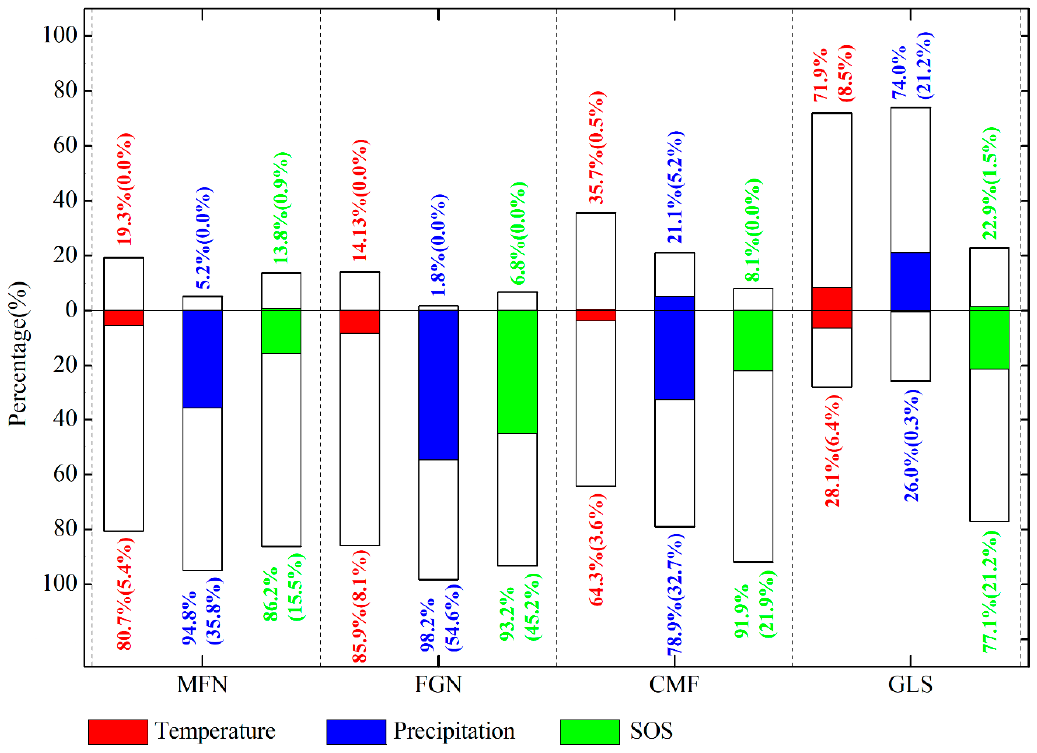
Figure 9. Percentages of the partial correlation coefficients between EOS and preseason temperature, precipitation, and SOS of each ecogeographical region in the Greater Khingan Mountains from 1982 to 2015. Bars above 0 and below 0 represent the percentage of positive and negative correlations, respectively. Colored sections show the percentage of significant correlations at p < 0.05.